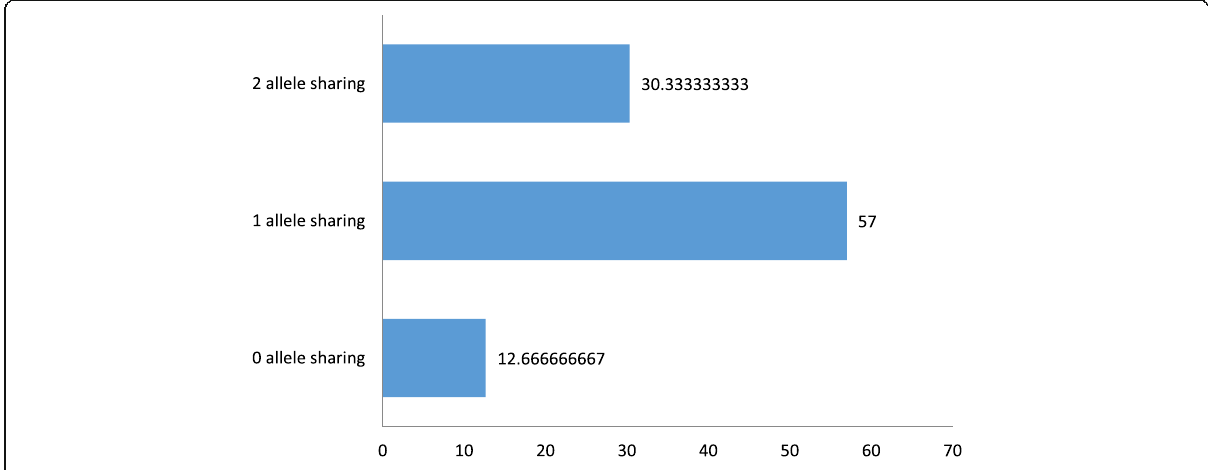
Fig. 4 Combined average of shared allele on two, one, and zero allele sharing in full sibling by 12 STR